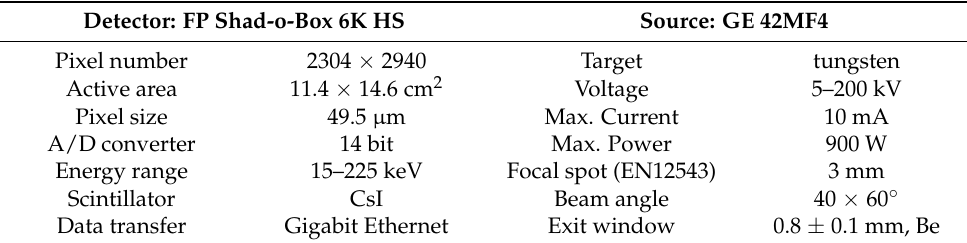
Table 1. Technical specifications of the main instrumentation used for the analysis.